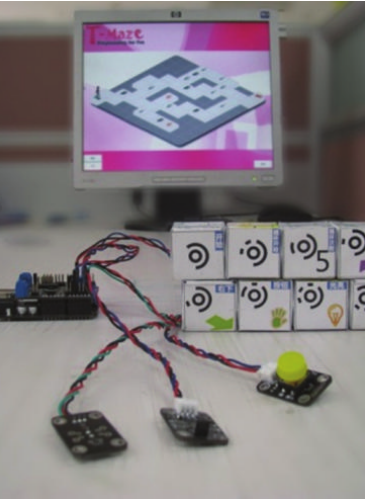
Figure 1: T-Maze overview: sensors, wooden blocks, camera, and